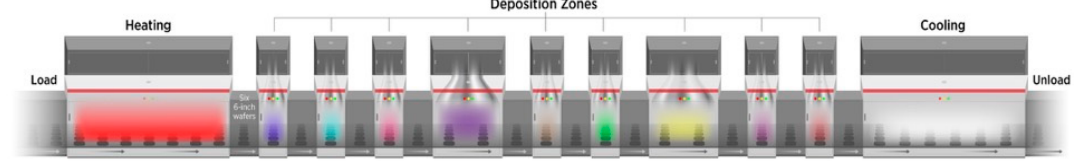
Figure A1. Diagram showing the concept of the high-volume, in-line HVPE tool used for cost analysis. In our model, there is one deposition zone, per layer, in the device.